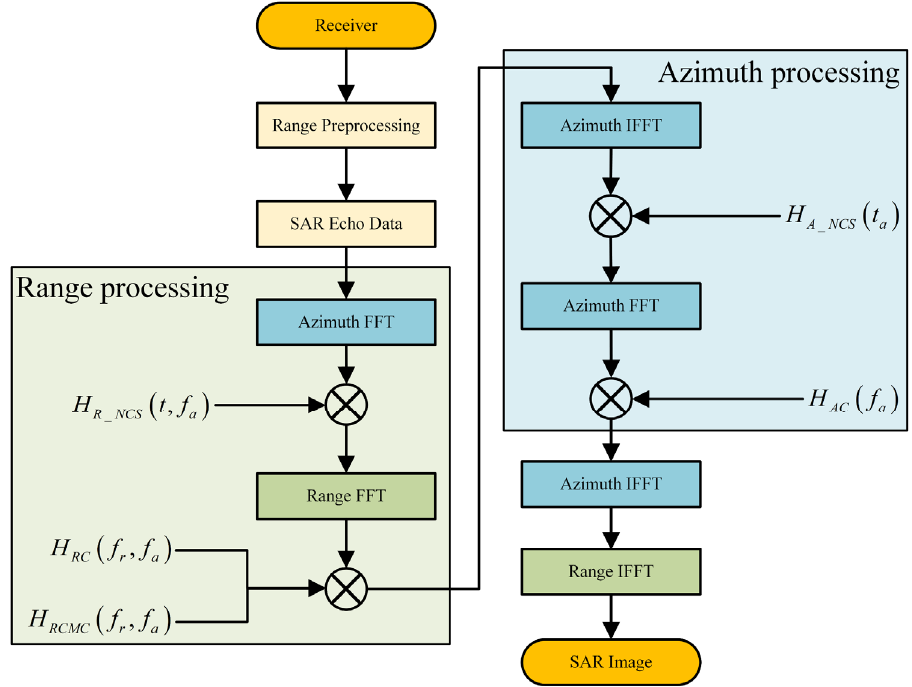
Figure 12. Block diagram of the proposed algorithm.